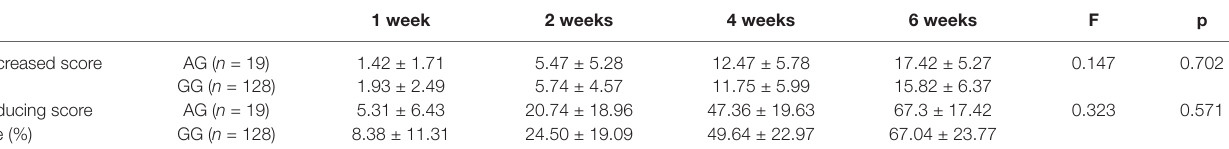
TABLE 5 | Rs2235040 and response to antidepressants.